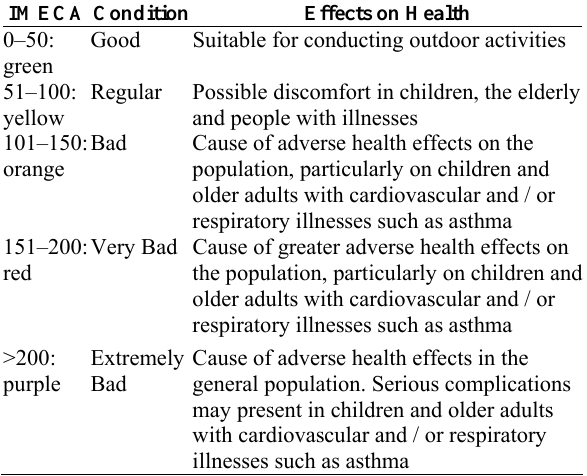
Table 1. IMECA and its implications for